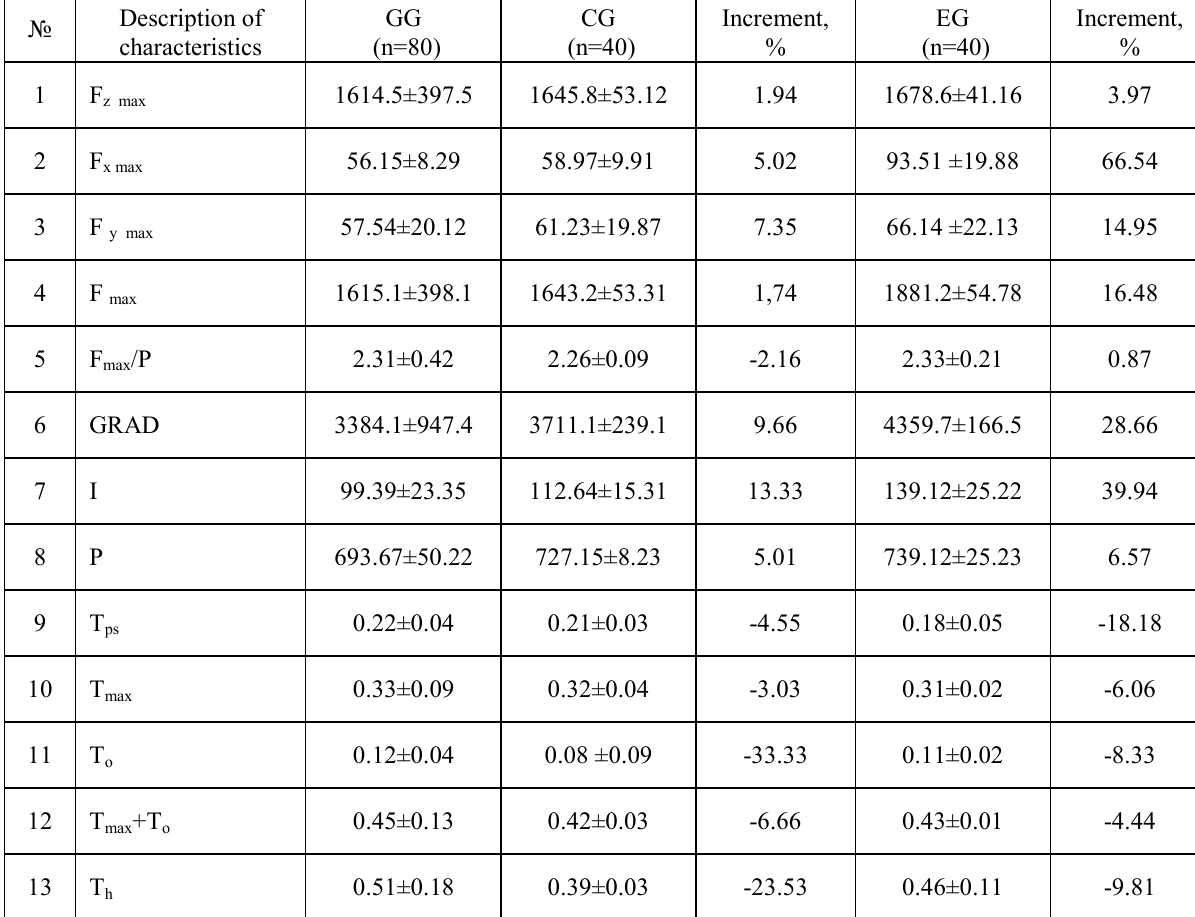
Mean statistic indicators of support responses of body of physical education faculty students when fulfilling